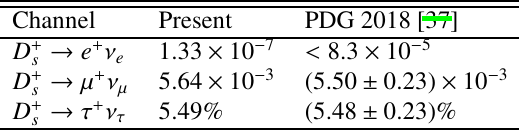
-decay branching fraction ( τ D + s